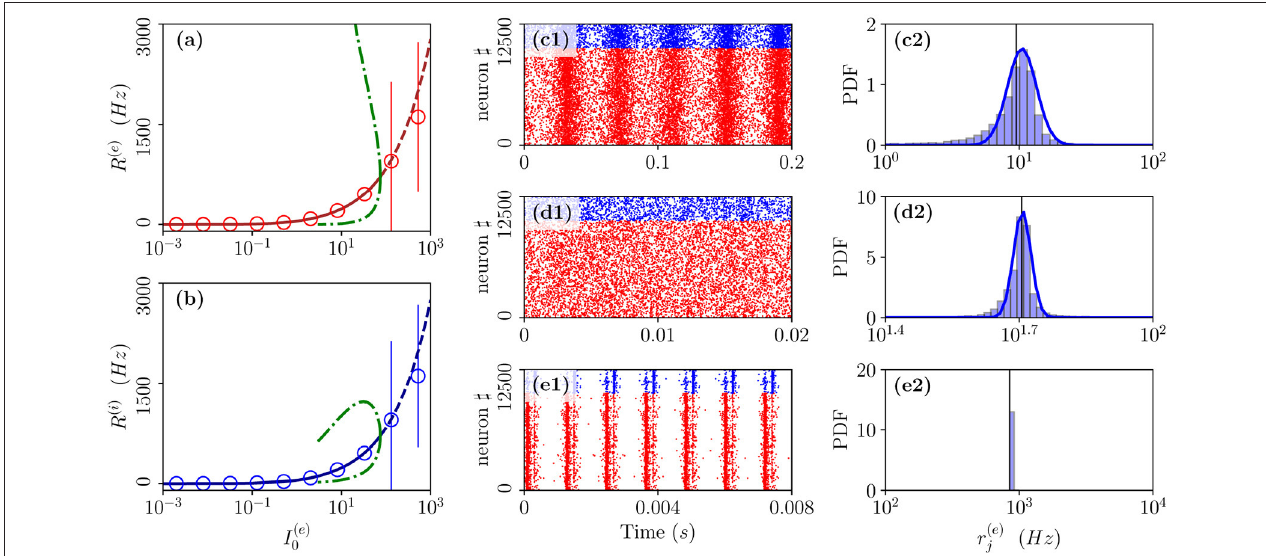
FIGURE 7 | From fluctuation driven to abnormally synchronized oscillations. Firing rates R ( e ) (a) and R ( i ) (b) as a function of I ( e ) 0 for E-I network (circles) and neural mass model (lines) for the parameter cut corresponding to the dashed purple line in Figure 1A . For the neural mass model: solid (dashed) line shows stable (unstable) focus solution R ( e ) and R ( i ) ; green dot-dashed lines refer to the extrema of R ( e ) ( R ( i ) ) for the unstable LC present in region (II). The unstable LC emerges at the sub-critical HB for I ( e ) 0 74.1709 separating region (II) from (I), where the focus becomes unstable. Raster plots and PDFs of the excitatory firing rates r ( e ) j are reported for specific = cases: namely, I ( e ) 0 0.128 (c1,c2) , I ( e ) 0 1.024 (d1,d2) , and I ( e ) 0 100 (e1,e2) . The solid vertical lines in (c2,d2,e2) refer to the mean firing rate. Parameters as in = = = 1.58, K =1,000 N ( e ) 10,000, and N ( i ) 0.3, 1 ( ee ) 0 Figure 1 , other parameters are set as 1 ( ii ) 0 = = = =